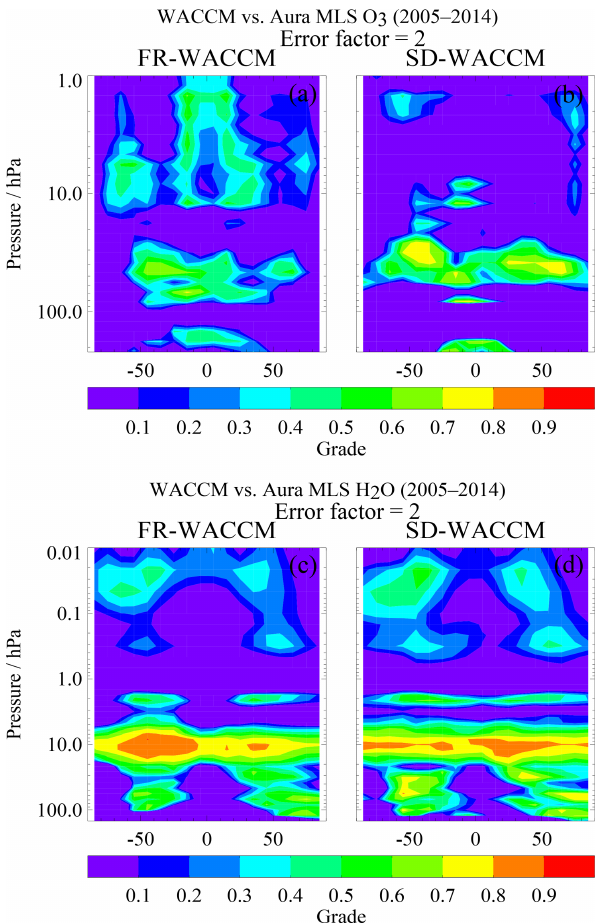
Figure A2. As in Fig. A1, for model evaluation grades of O 3 and H 2 O (WACCM versus Aura MLS data), but for a value of 4 (rather than 2) for the error factor (see Eq.